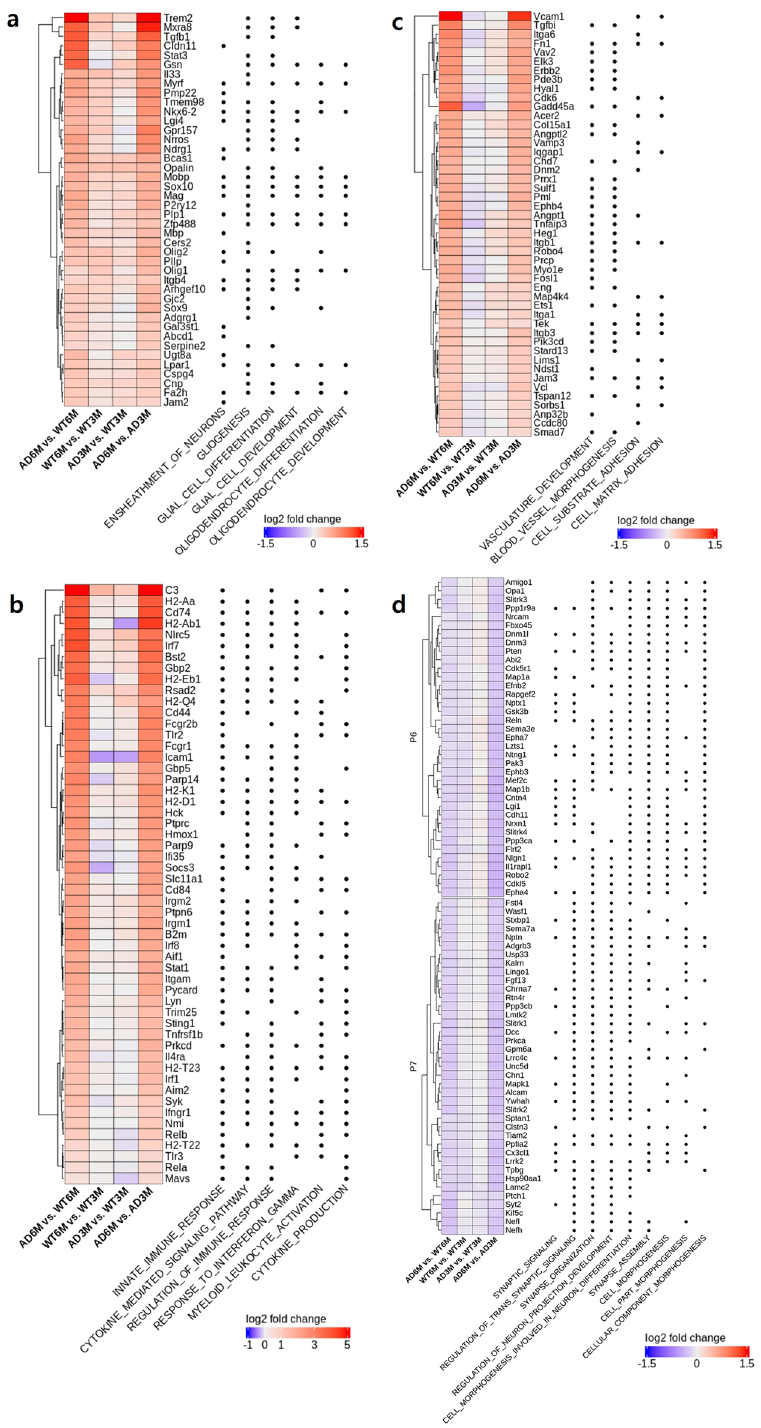
Figure 3. Recurrently annotated genes were selected and are shown with the associated Gene Ontology biological process terms. The numbers of genes were as follows: ( a ) 42 in P1, ( b ) 54 in P2, ( c ) 47 in P3, ( d ) 37 in P6, and 39 in